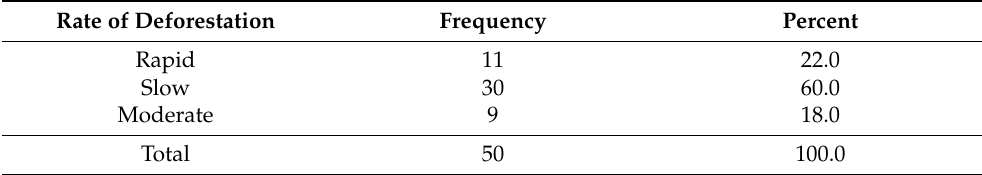
Table 13. Rate of deforestation in Tehsil Murree. Rate of Deforestation Frequency Percent Rapid 11 22.0 Slow 30 60.0 Moderate 9 18.0 Total 50 100.0 People Dependency on Forest for